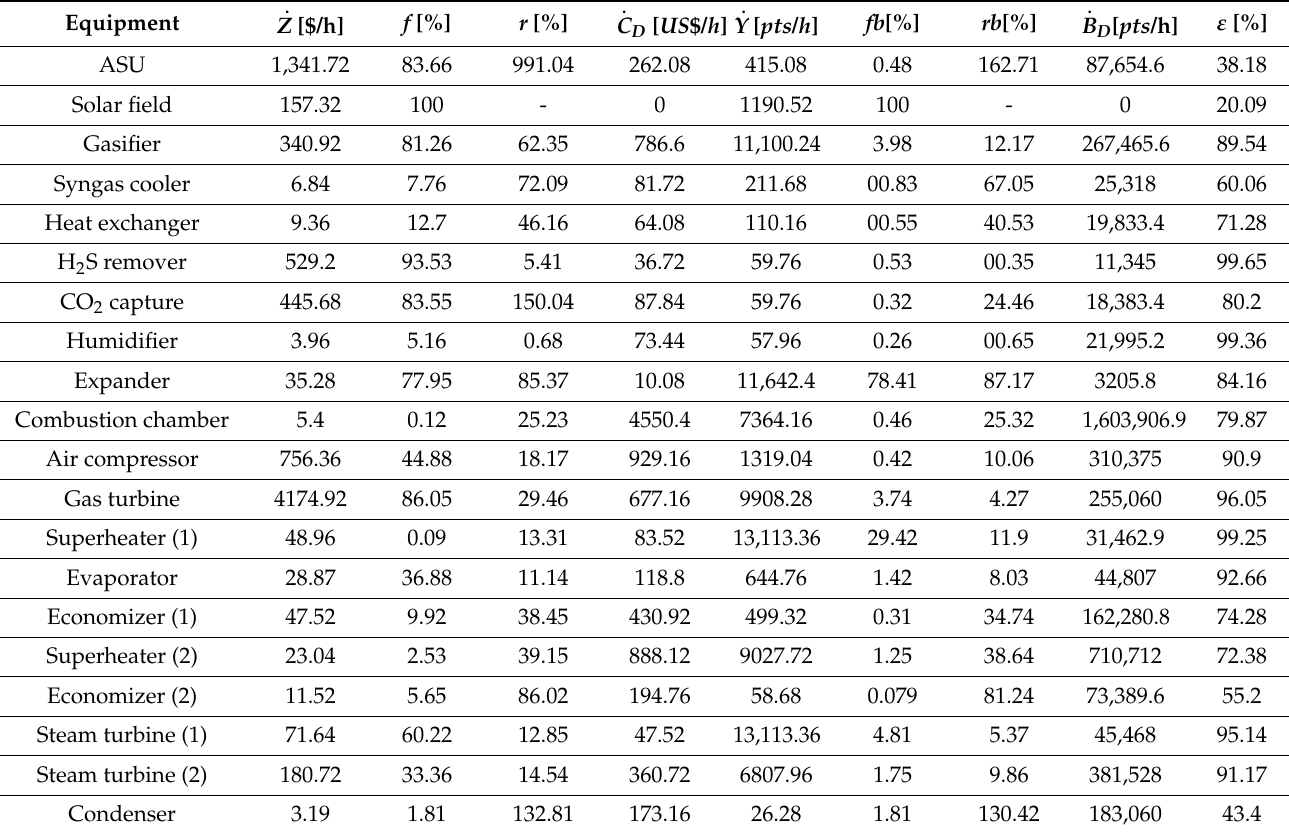
Table 6. Results obtained from conventional exergy, exergoeconomic, and exergoenvironmental analyses for the different system